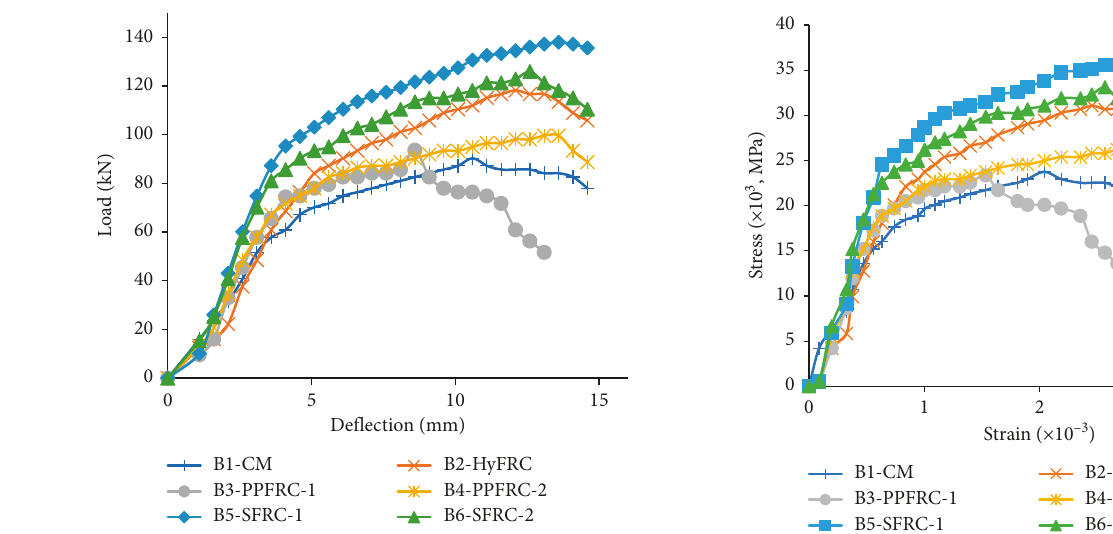
Figure 11: Stress-strain curves of all girders. Figure 10: Load-deflection curves of all